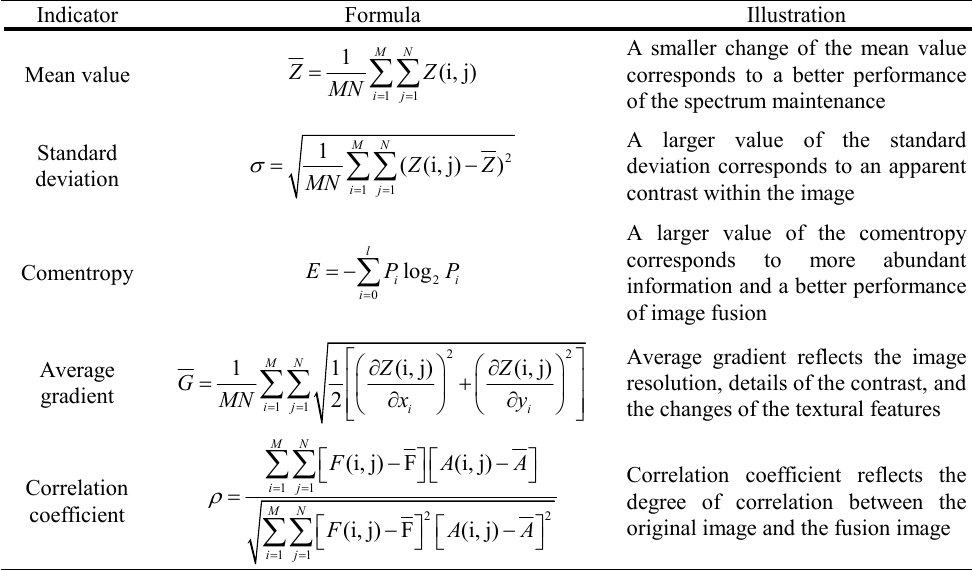
represents the gray